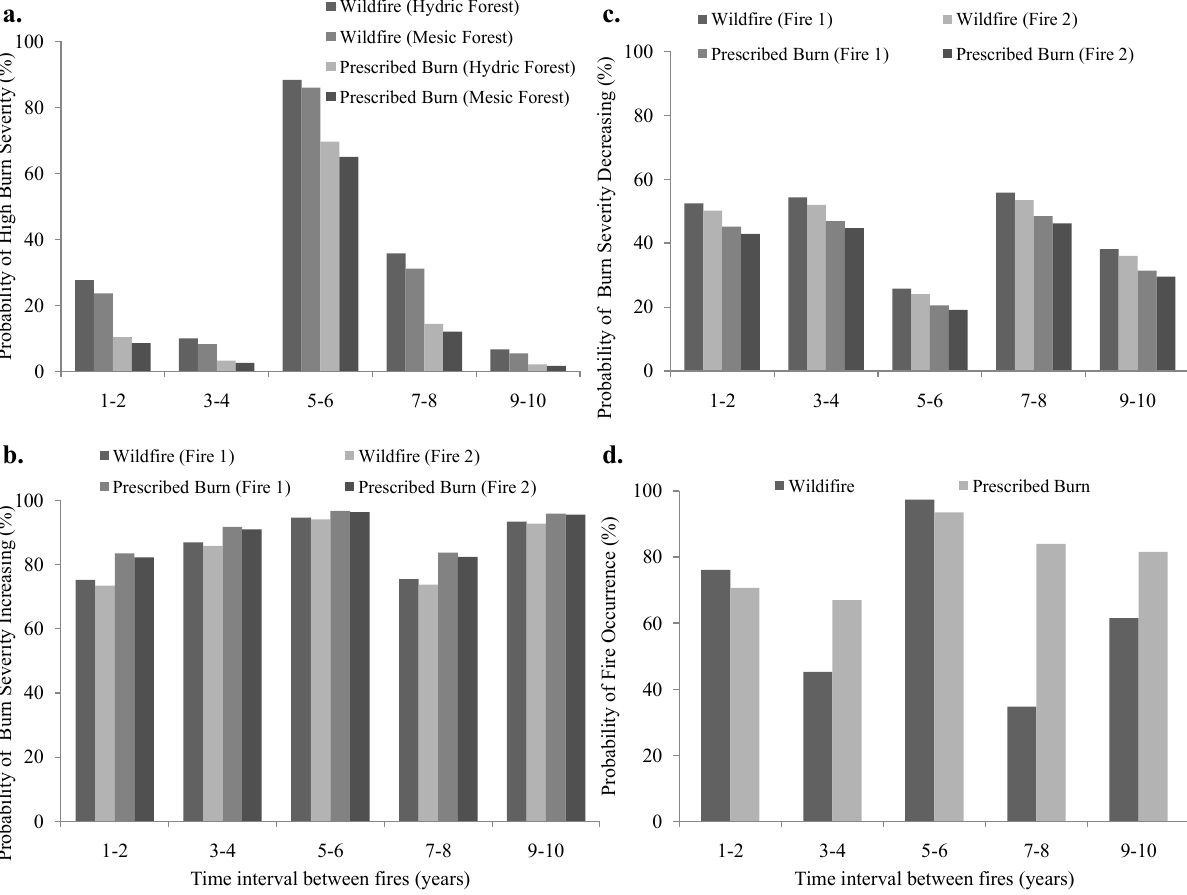
Figure 2. The relationship between time since last fire and: ( a ) the probability of high burn severity; ( b ) the probability of increasing burn severity; ( c ) the probability of decreasing burn severity; and ( d ) the probability of fire occurrence in subsequent fire by fire